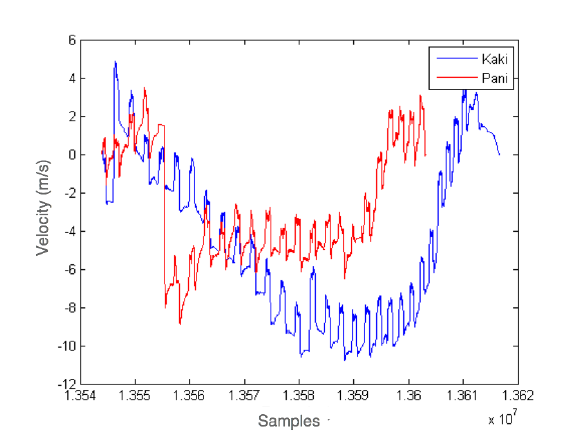
Figure 7. Velocity evolution of two sportsmen at